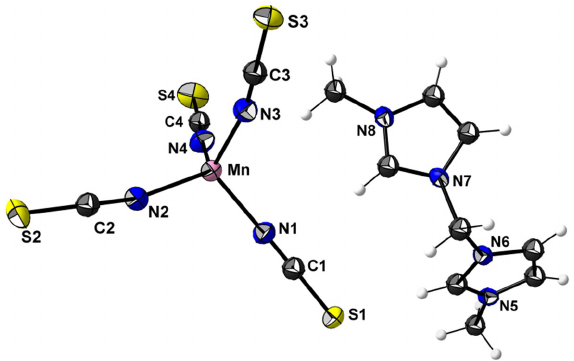
Figure 1. Molecular structure of (DMDIm)[Mn(NCS) 4 ] with labeling of selected atoms. Thermal displacement ellipsoids are drawn at the 50% probability level.